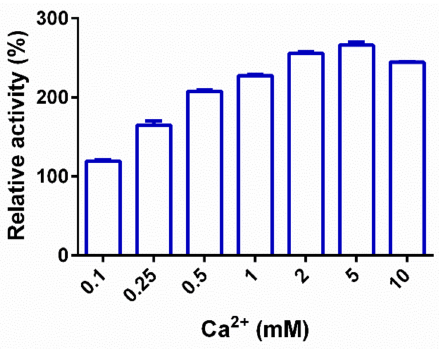
Figure 5. E ff ect of Ca 2 + on the activity of PpPel9a. Values represent the mean ± SD ( n =